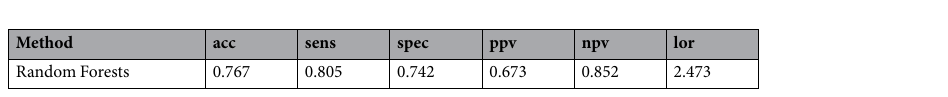
Table 14. Fine-tuned RF classification results on the Tel-Aviv dataset.